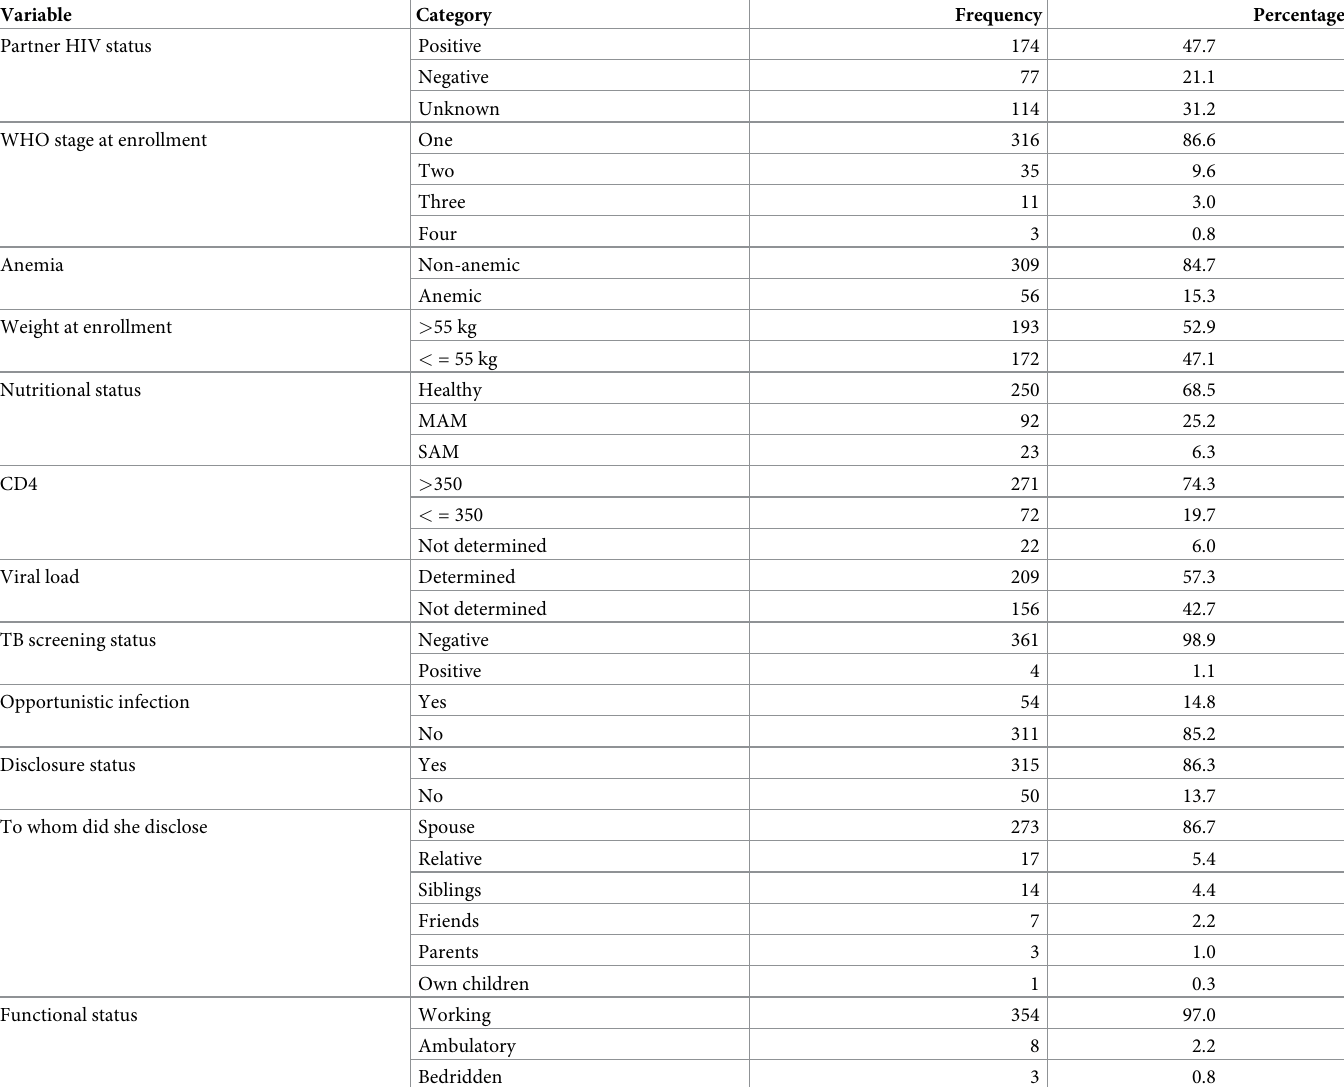
Table 2. Baseline clinical characteristics of women on option B+ PMTCT program in Pawi district health facilities, northwest Ethiopia, June 2013- March